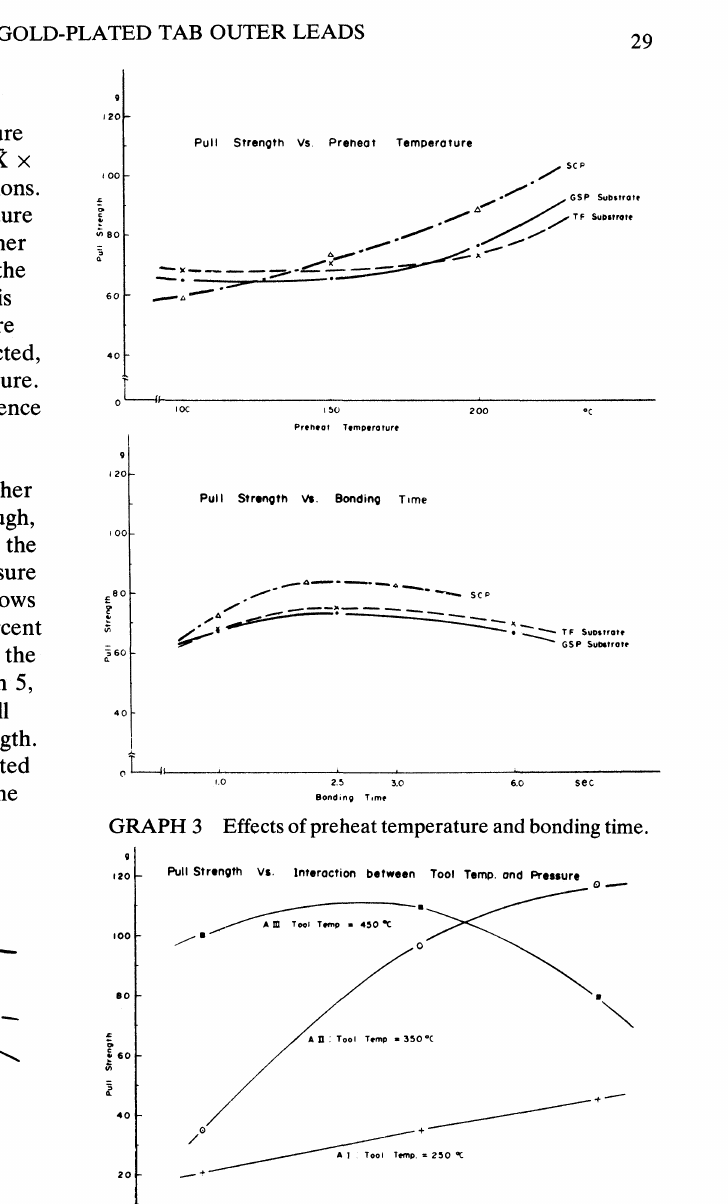
GRAPH 4 Effects of interaction between tool temperature and